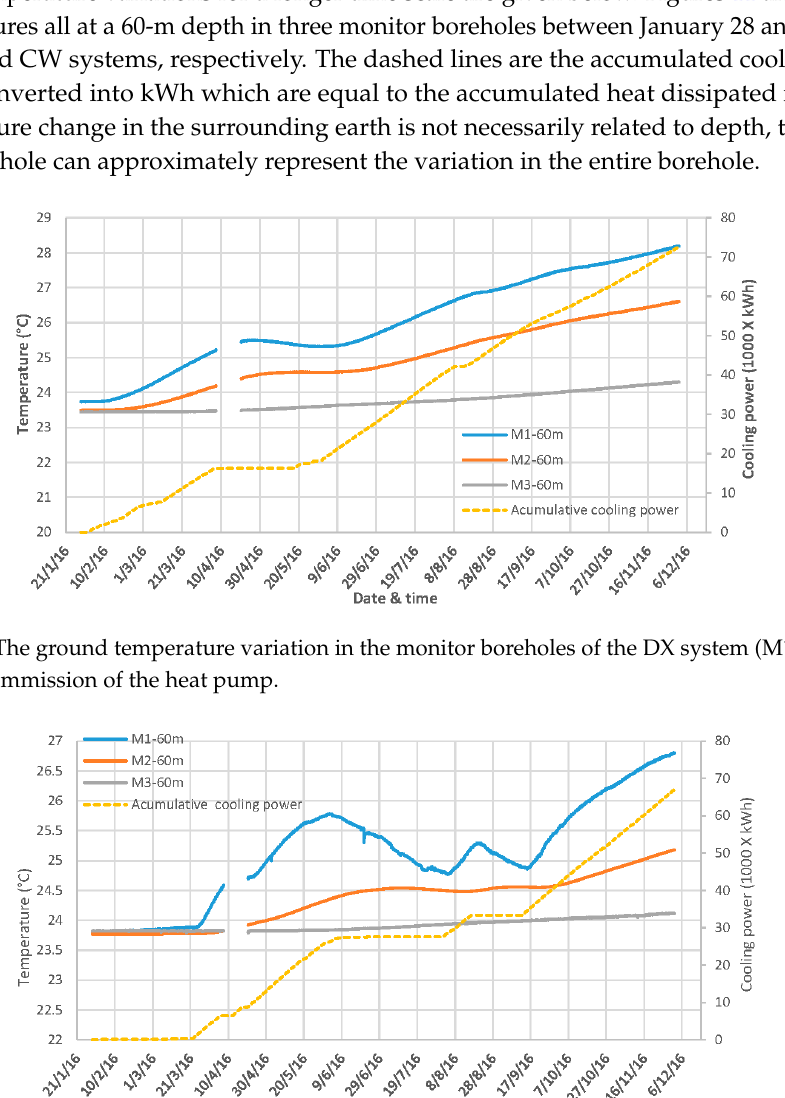
Figure 10. Monitoring boreholes (M1, M2, M3) temperatures of CW system from August 1 to August 22, 2016.